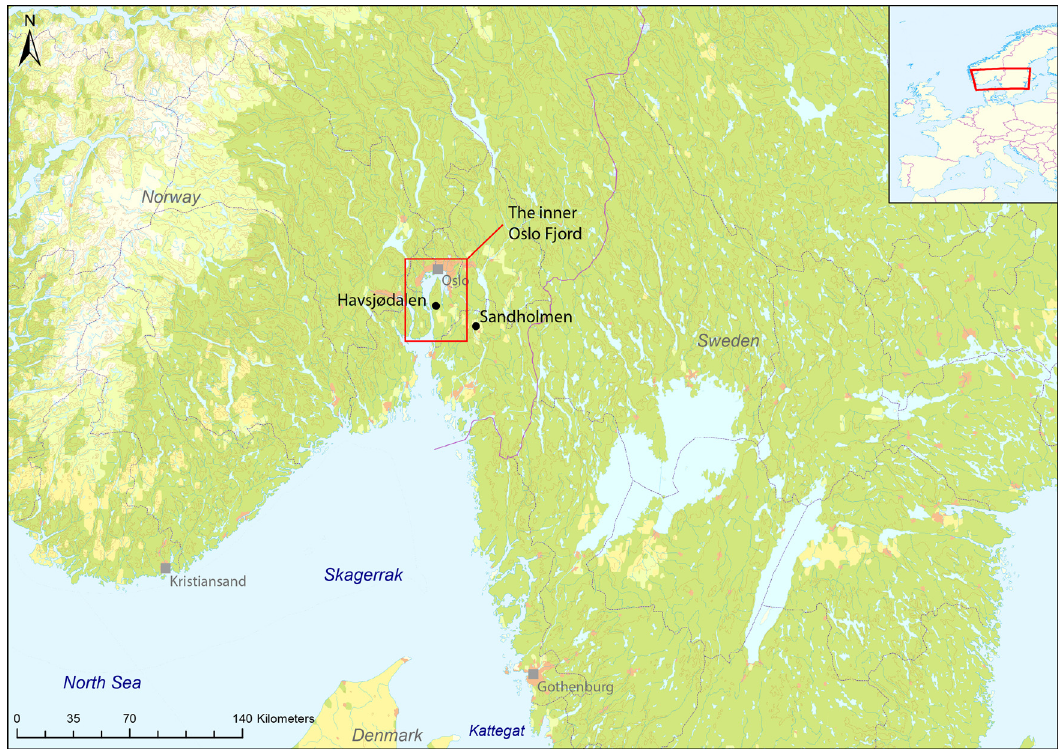
Figure 1: The studied area in the innermost part of the Oslo Fjord in eastern Norway. Map: Axel Mjærum, Museum of Cultural